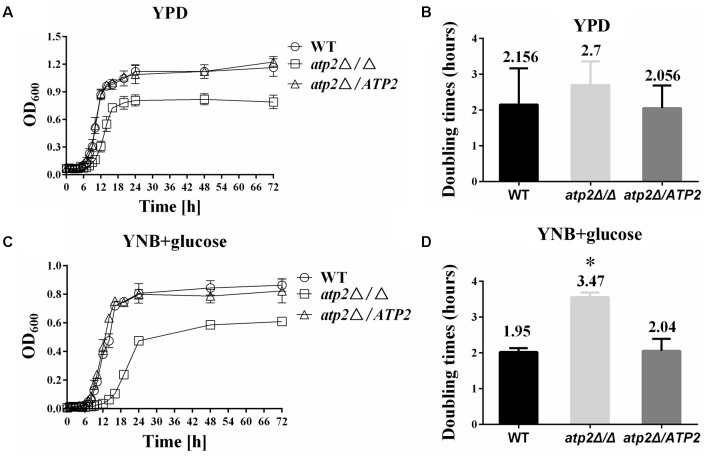
Deletion of ATP2 results in a longer generation time. The growth curves of strains WT, atp2Δ/Δ and atp2Δ/ATP2 are shown. Strains were grown overnight in YPD, transferred to fresh rich (YPD) or minimal (YNB) media at an OD600 of 0.02, and incubated at 30°C. The absorbance was measured every 1 h for 48 h and the generation times were calculated. The growth (A,C) (OD600) and the generation times (B,D) of all strains were monitored when cultures were grown on rich (A,B) and minimal media (C,D). The growth curves represent the averages of three experiments and three replicates per time point per strain. ∗P < 0.05 compared with WT. Representative results from at least three experiments are shown.